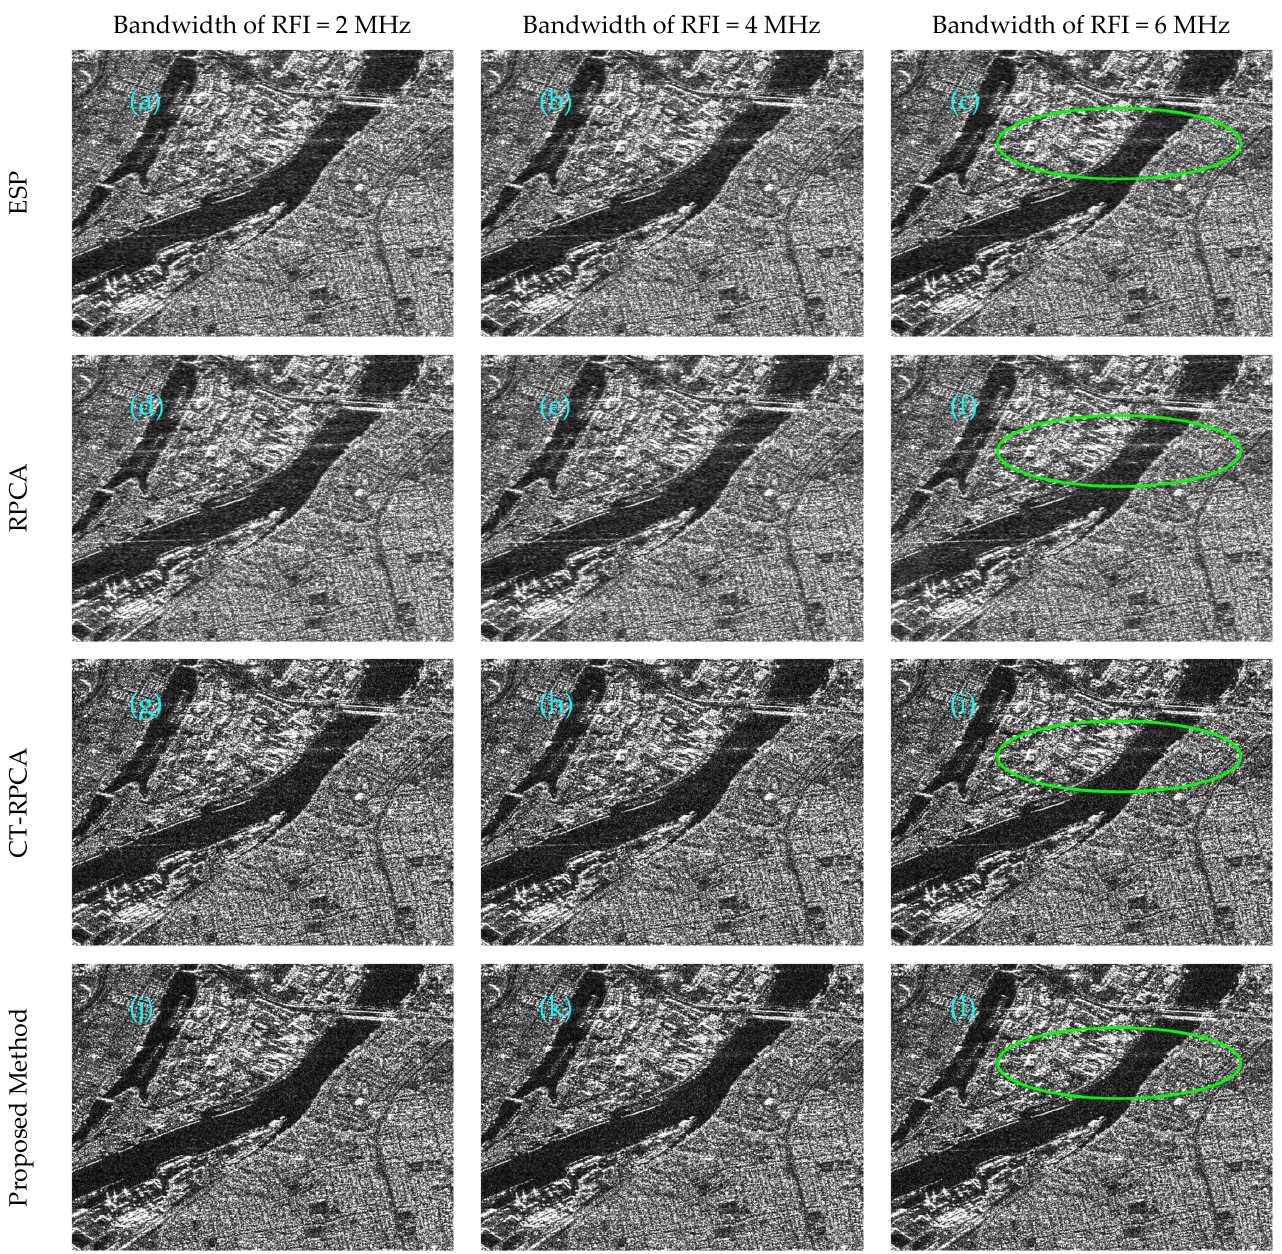
Figure 9. ROIs in Figure 8. ( a – c ) Mitigation results for the ESP method. ( d – f ) Mitigation results for the RPCA method. ( g – i ) Mitigation results for the CT-RPCA method. ( j – l ) Mitigation results for the proposed approach.